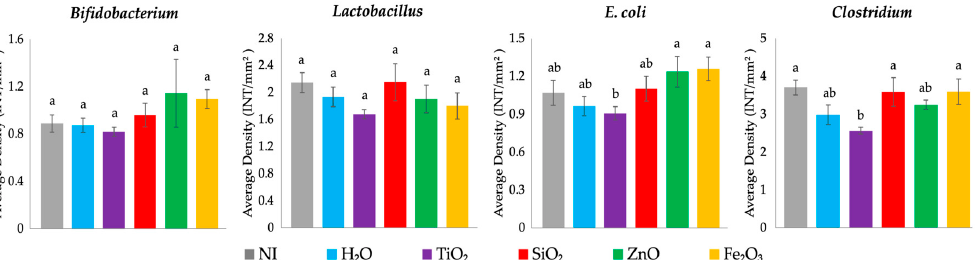
Figure 4. Effects of intraamniotic injections of food-grade NP on cecal genera ( Bifidobacterium , Lactobacillus , and Clostridium ) and species-level bacterial populations ( E. coli ) on day of hatch. Values are presented as means ± SEM, n = 5. a,b Per bacterial category, treatment groups that do not share letters significantly differ according to one-way ANOVA with post hoc Duncan test ( p < 0.05). NI = non-injected. Table 5. Effects of intraamniotic administration of experimental food-grade NP solutions on duodenal small intestinal villi and depth of crypts 1 .